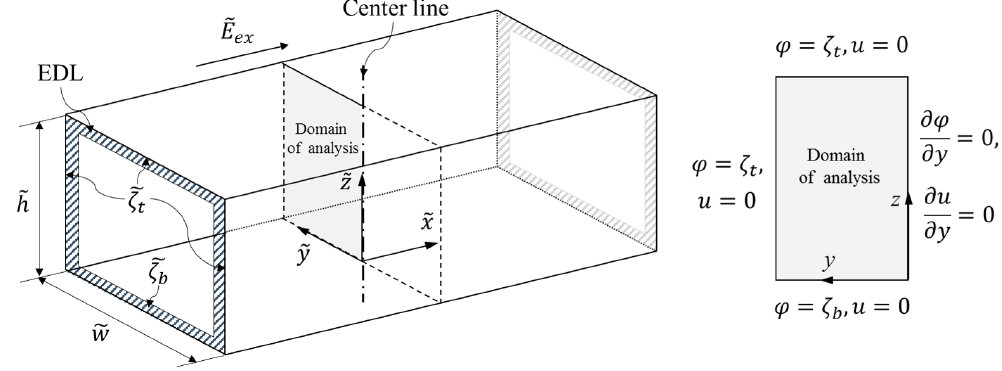
Figure 1. Schematic diagram of electroosmotic flow in a rectangular microchannel and boundary conditions.